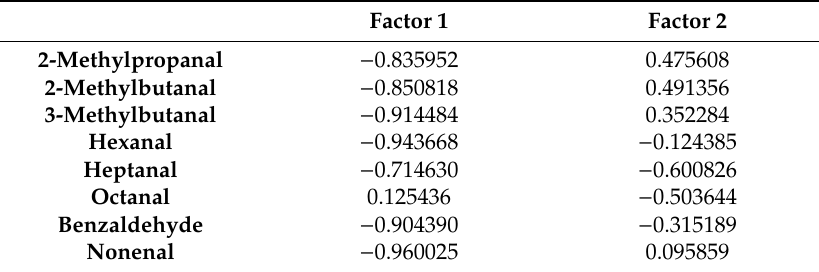
Figure 2. Principal component analysis according to the content of staling aldehydes in beers processed at different pressures (250 MPa or 550 MPa) and stored in cold (8 °C) or at room temperature (22 °C) for 1 or 2 months. Control sample was beer untreated by pressure processing. Particular samples are coded according to the type of treatment as listed in Table 2. Samples are clustered in 3 groups according to the type of processing (untreated, processed at 250 MPa or at 550 MPa). Table 3. Factor contributions (loadings) of the individual carbonyl